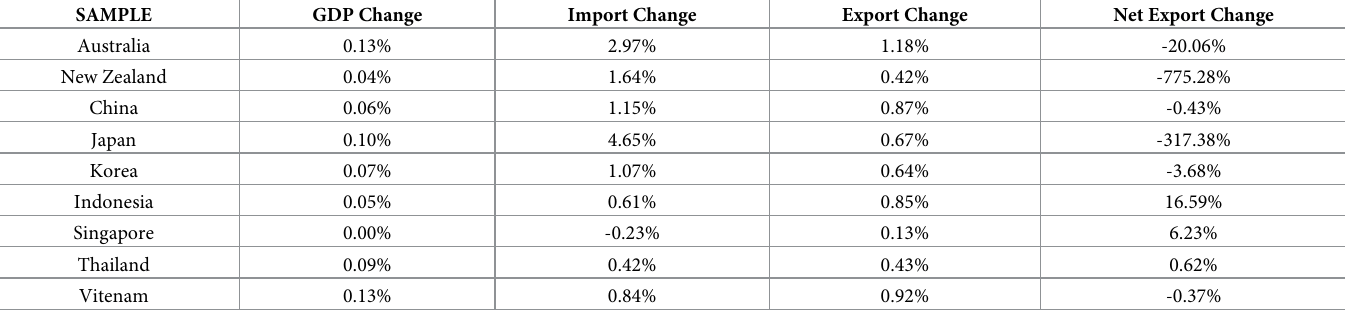
Table Note. All of these data are predicted by